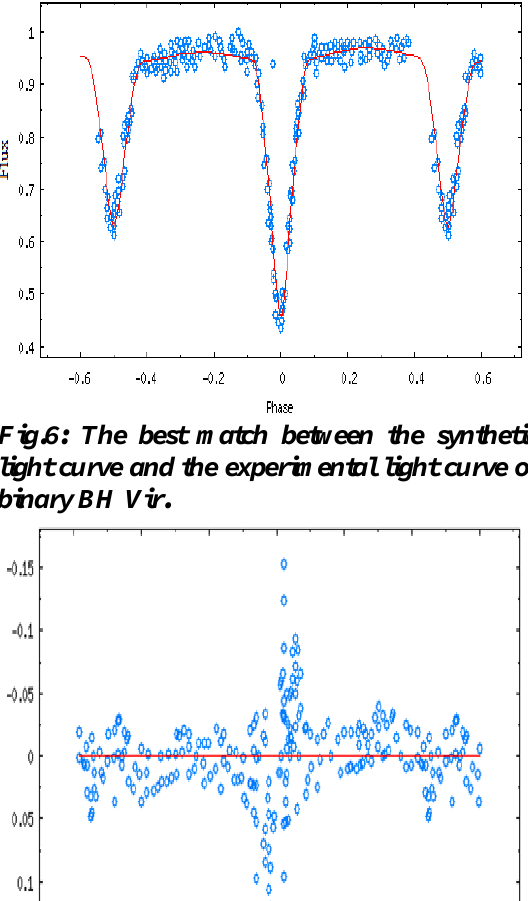
Fig.10: The shape of BH Vir binary star at different